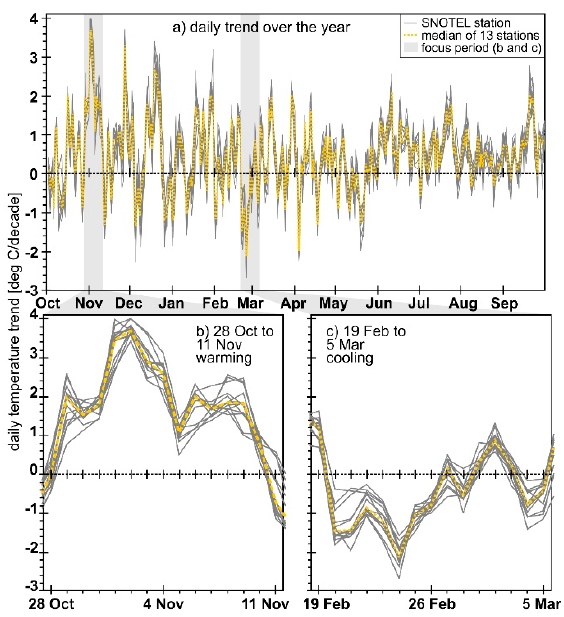
Figure 6. Daily temperature trends for the 13 SNOTEL stations plus the median of the trends for ( a ) the entire year, ( b ) the greatest warming period (28 October to 11 November), and ( c ) the greatest cooling period (19 February to 5 March).